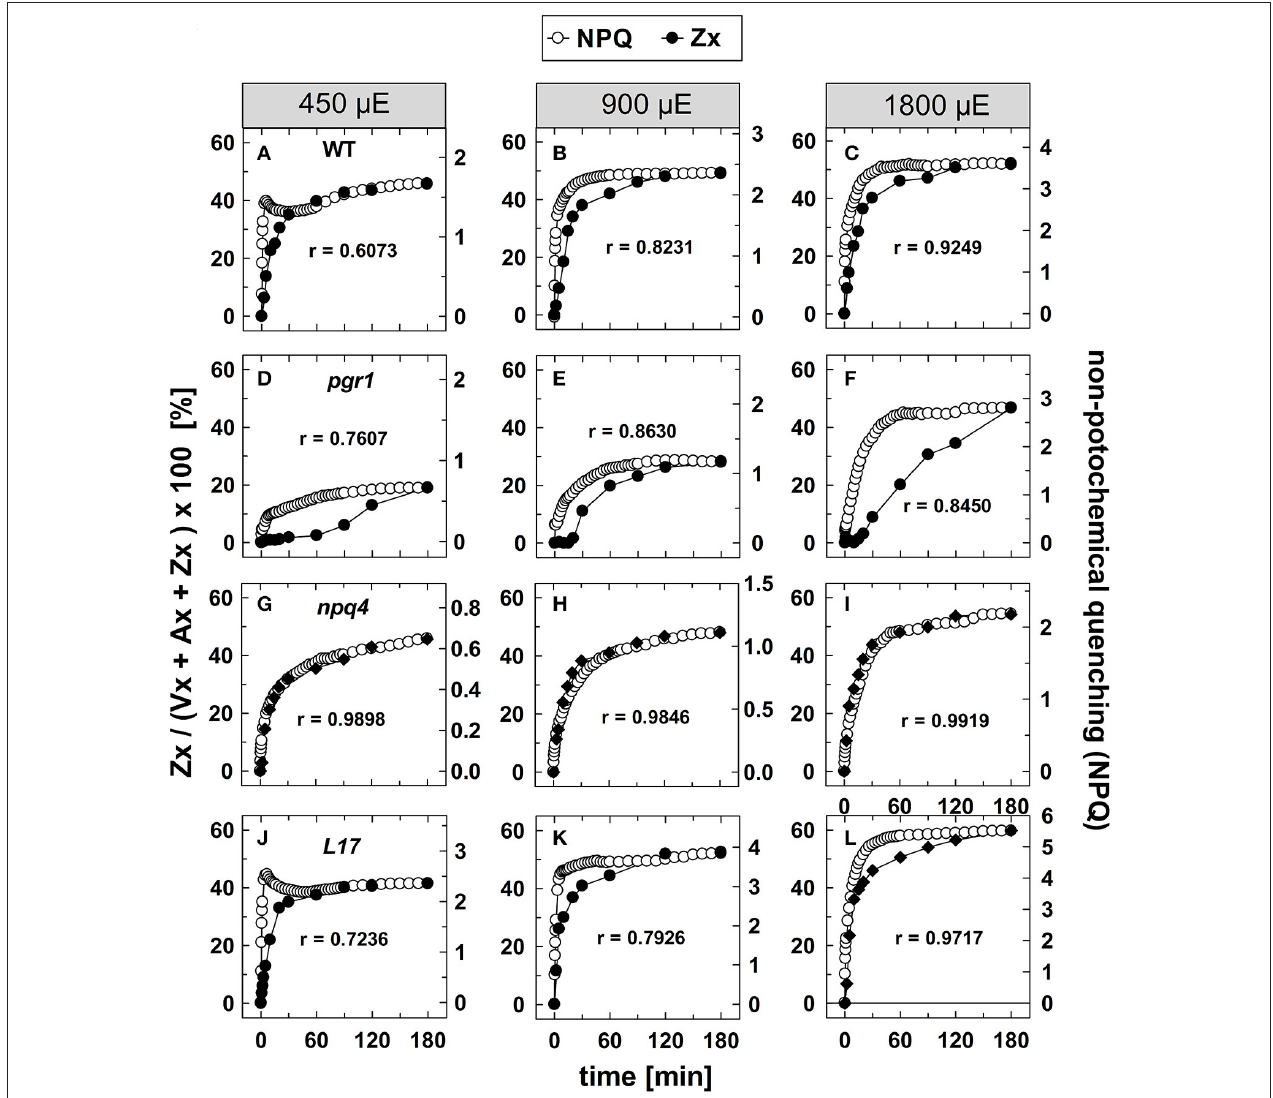
FIGURE 4 | Comparison of NPQ induction and Zx synthesis. The time course of NPQ induction and Zx synthesis is compared for the four genotypes with an active xanthophyll cycle for the three actinic light intensities of 450, 900, and 1,800 µ E: (A–C) WT, (D–F) pgr1 , (G–I) npq4, and (J–L) L17 . The data were taken from Figure 1 (NPQ) and Figure 3 (Zx). The determined Pearson’s correlation coefficient r is indicated in each